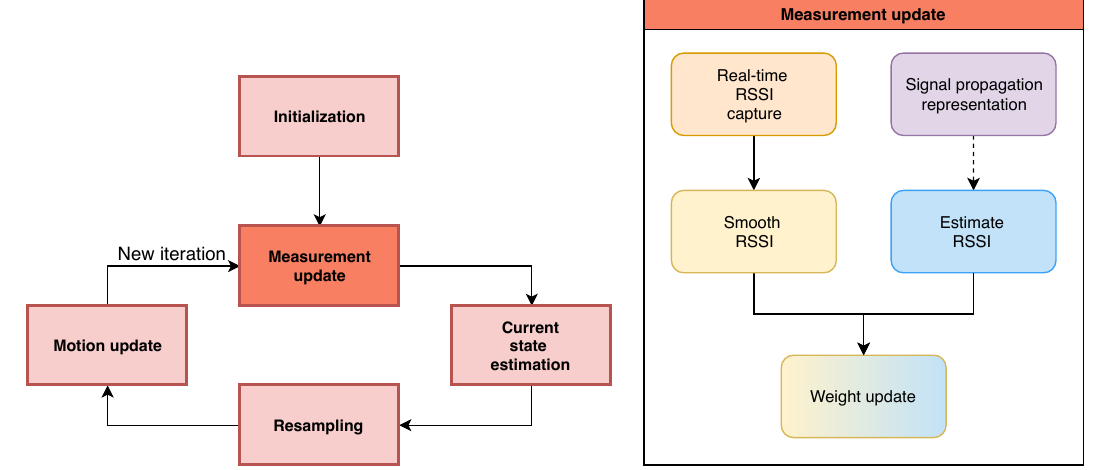
Figure 7. Indoor tracking algorithm: workflow ( left ) and detailed measurement update stage ( right